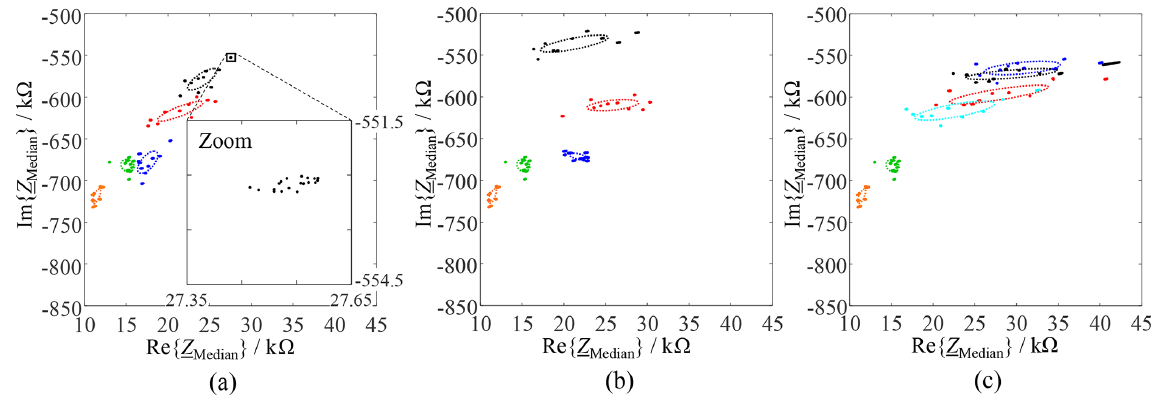
Figure 7. Distribution of the “median” feature for repeated measurements of various MUTs. Color coding as in Fig. 6. (a) MUT 1a and b and MUT 2a to c. (b) MUT 1a and b and MUT 3a to c. (c) MUT 1a and b and MUT 4a to d. The 20 repeated measurements with a given cell filling scatter so little that the 20 individual points can hardly be resolved in this representation. The zoomed-in view in (a) provides a better resolution of one point cloud by way of an example.